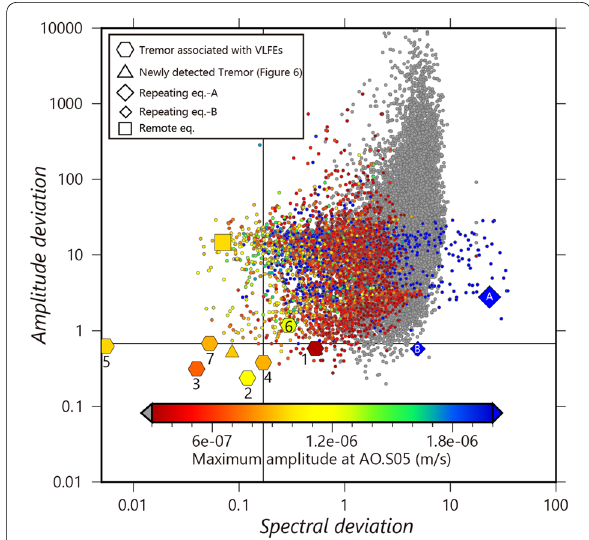
Fig. 7 Results of waveform classification using amplitude deviation and spectral deviation for the six days when the reported very low frequency earthquakes (VLFEs) occurred. Hexagons represent tremors #1–7, diamonds represent repeating earthquakes, and a square represents remote earthquake. Symbol colors show the maximum amplitude at station AO.S05 at the corresponding time window. Thresholds of spectral and amplitude deviations are shown by vertical and horizontal lines, respectively. The spectral and amplitude deviations calculated for repeating earthquake-A, repeating earthquake-B, and a remote earthquake are also shown, although these earthquakes occurred on different days. The spectral deviation of tremor #5 is not exactly zero in the figure since the time window including tremor #5 in the event search is slightly different from that for the reference power spectral density